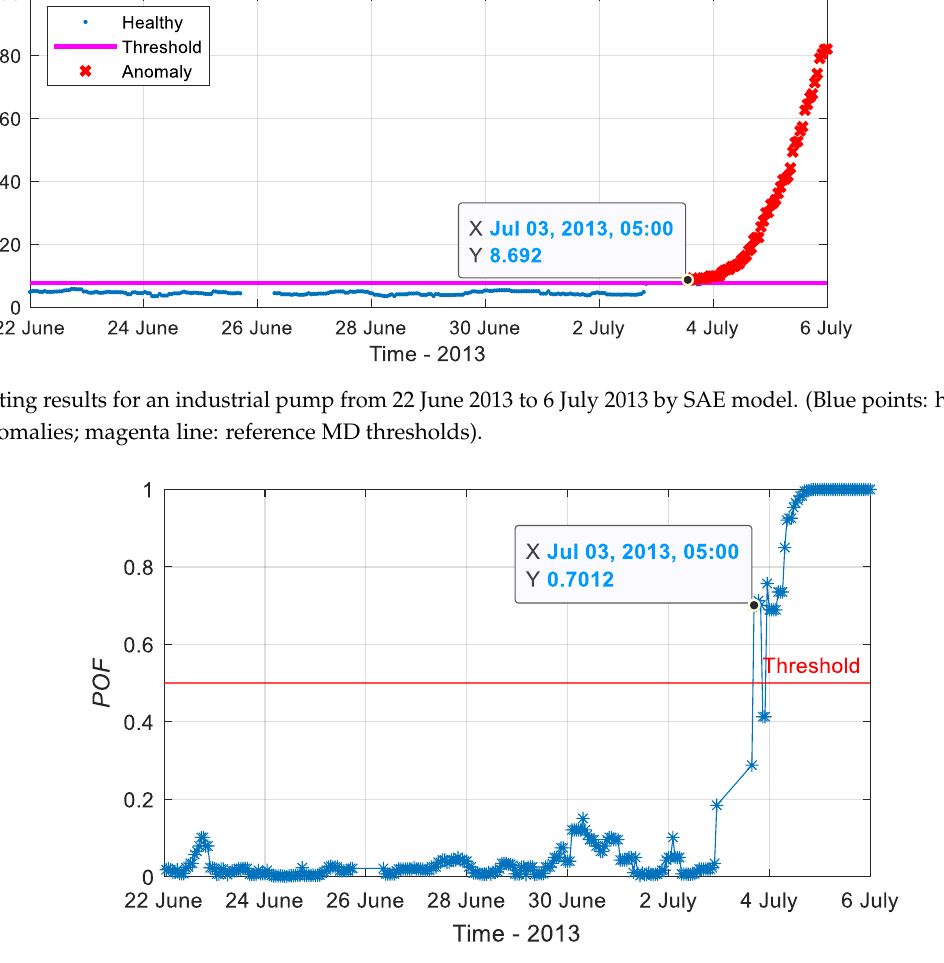
Figure 9. POF of the pump system obtained by SAE in the online phase (red line: fault detection threshold d 1